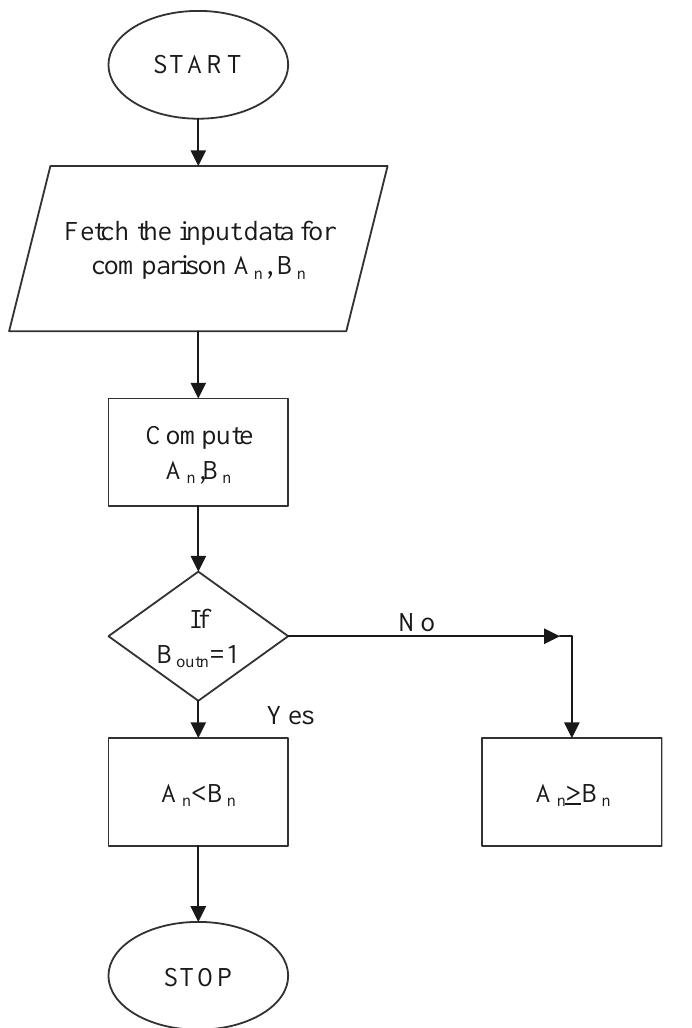
Figure 14. Flowchart to design a magnitude comparator using